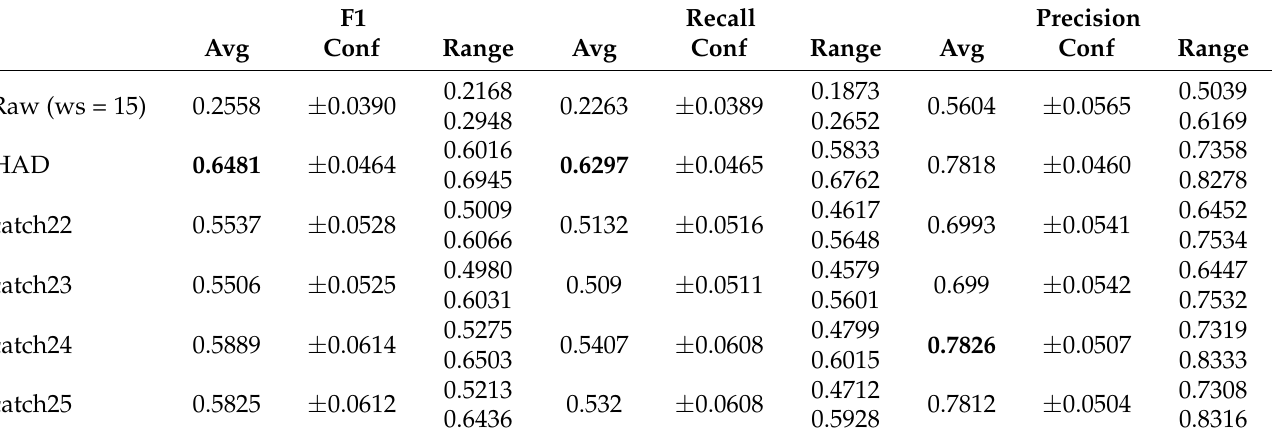
Table 3. For each feature set under test, the mean F1, recall, and precision, along with confidence intervals calculated to 95% and range calculated across model types and dataset fold combinations (populations sizes: 157, 179, 172, 172, 151, and 151). Bold font indicates highest score for a metric. F1 Recall